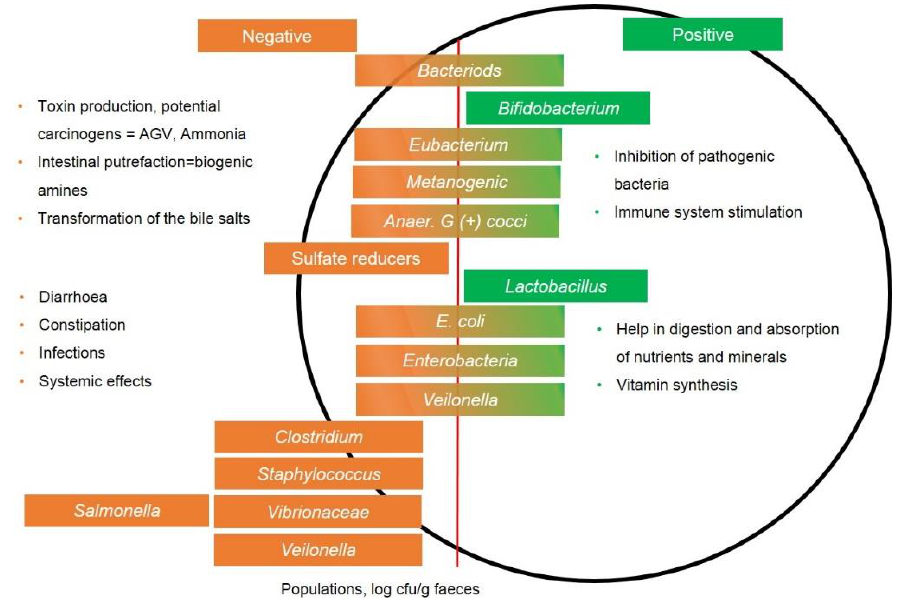
Figure 2. Role of gut microbial communities in the gastrointestinal tract (GIT). Green indicates the beneficial effects, and orange indicates the harmful effects of GIT bacteria. E. coli, Escherichia coli.